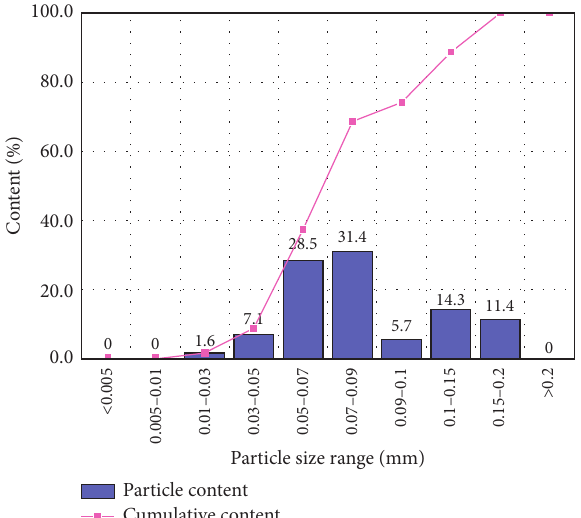
Figure 9: Particle size distribution of quartz grain.